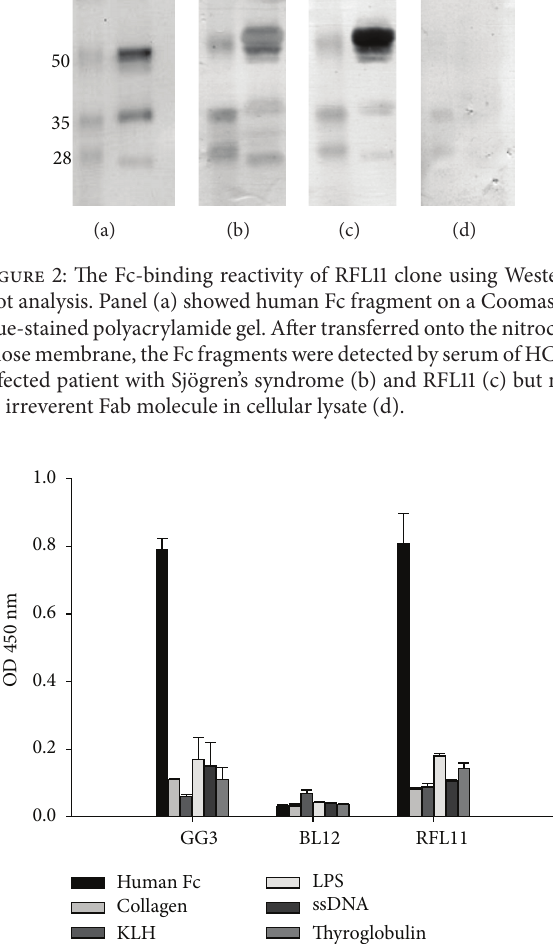
Figure 3: The binding specificities of the RFL11-Fc binder. Fab molecules were analyzed comparatively against Fc fragment and a panel of five unrelated antigens, including collagen, KLH, LPS, ssDNA, and thyroglobulin. GG3 and BL12 denoted positive and negative Fab controls, respectively.